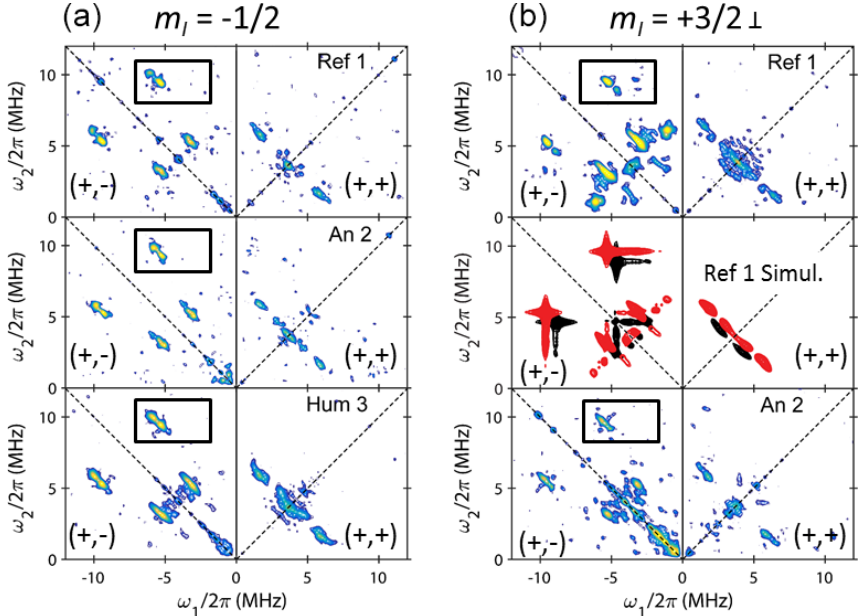
Figure 5. HYSCORE spectra at X band and at 6K of VO-P in Dead Sea asphalt Ref 1 and in black coating of the An 2 and Hum 3 mummies, recorded by observing (a) the m I = − 1 / 2 (341,6mT) and (b) the m I = + 3 / 2 ⊥ ( ∼ 355 , 6mT) hf lines marked by arrows in Fig. 2a. The correlation peaks described in more detail in Fig. 6 are delimited in rectangular boxes. Simulated spectra of VO-P1 (in red) and VO-P2 (in black) in the middle of (b)